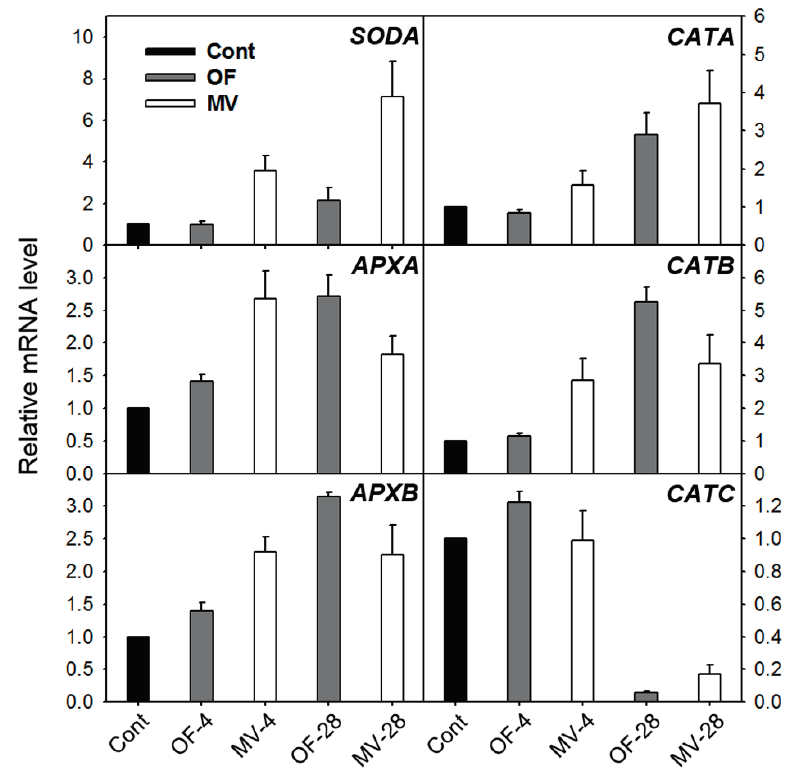
Figure 4. Expression of genes encoding the ROS-scavenging enzymes in rice plants with the foliar application of OF or MV treatment. Total RNAs were purified from plants and reverse transcribed. The resultant cDNAs were used as templates for qRT-PCR using Actin as an internal control. The control was used for normalization, with the expression level of the sample set to 1. Error bars represent SE, and representative data from three independent experiments are presented. The plants were subjected to the same treatments as in Figure